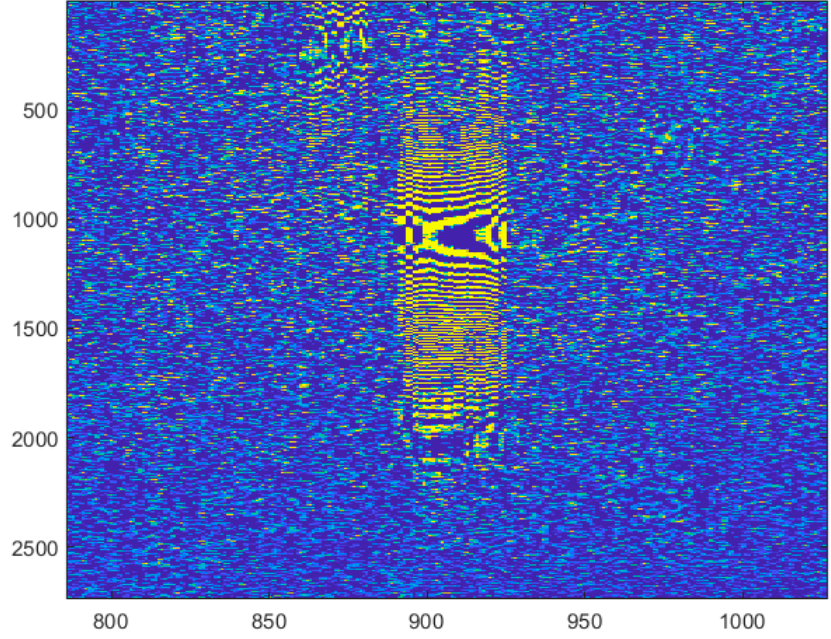
Figure 4. Part of the digital radio hologram of the mirror point on the surface.